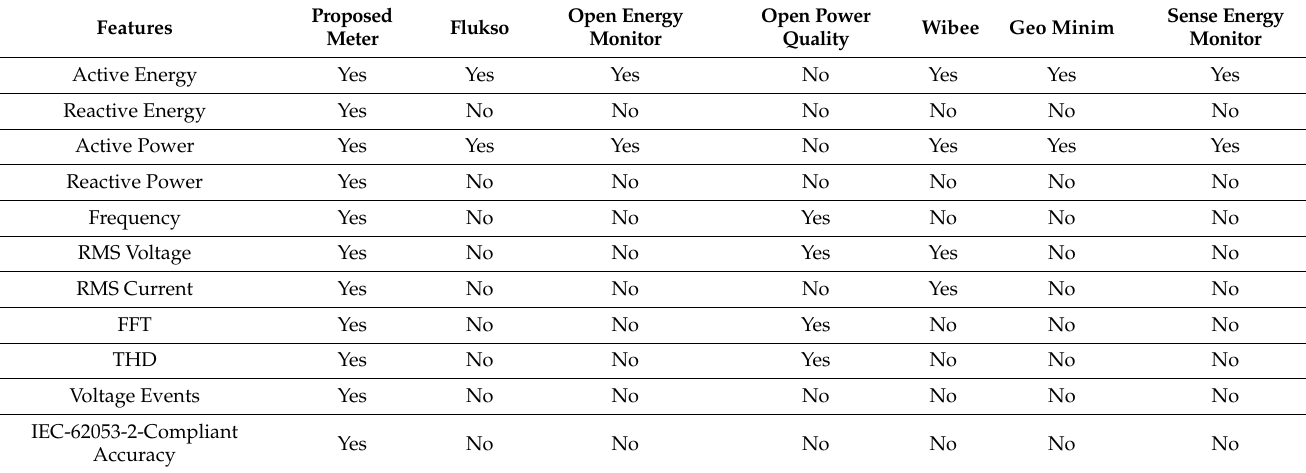
Table 1. Feature comparison with existing smart PQ